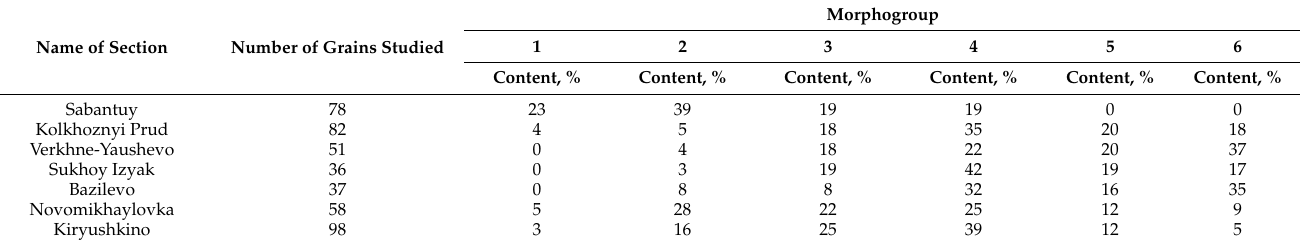
Table 1. Composition of morphogroups of chromian spinels in chromite paleoplacers of the Southern